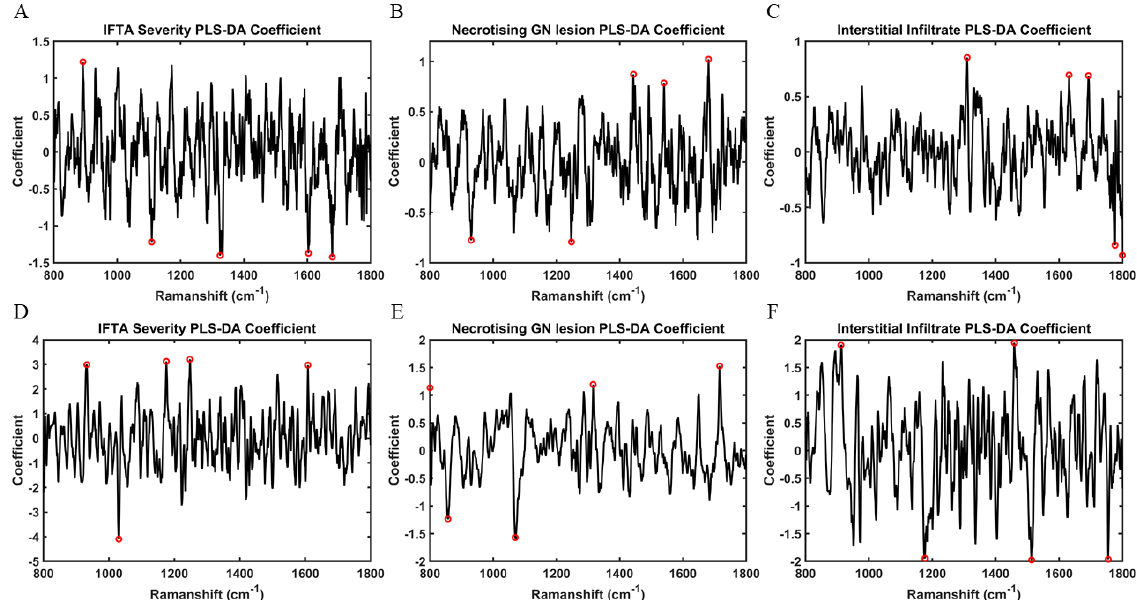
Figure 4. PLS-DA coefficients for identification of spectral biomarkers in tissue and correspond- ing paired urine samples (n = 10) —( A ) Wavenumber variables associated with interstitial fibrosis & tubular atrophy (IFTA) in tissue samples—891.92 cm − 1 (saccharide band) ( B ) Wavenumber variables associated with necrotising glomerular (GN) lesions in tissue samples—1680 cm − 1 (C=O, stretch- ing vibrations of cortisone), 1443 cm −1 (CH2 bending mode of proteins & lipids CH2 deformation),